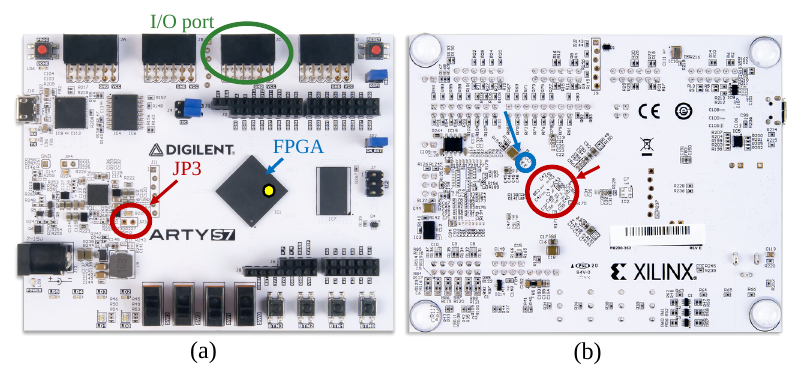
Figure 4: Digilent FPGA development kit. (a) Front side of the board. The area in red color shows the jumper used for bypassing the 10 mΩ shunt resistor. The highlighted area in green color shows one of the I/O ports. The highlighted point in yellow color on the FPGA shows the approximate location for the EM probe measurements with maximum coupling. (b) The backside of board. The areas in red and blue color show 47 nF and 470 nF decoupling capacitors,